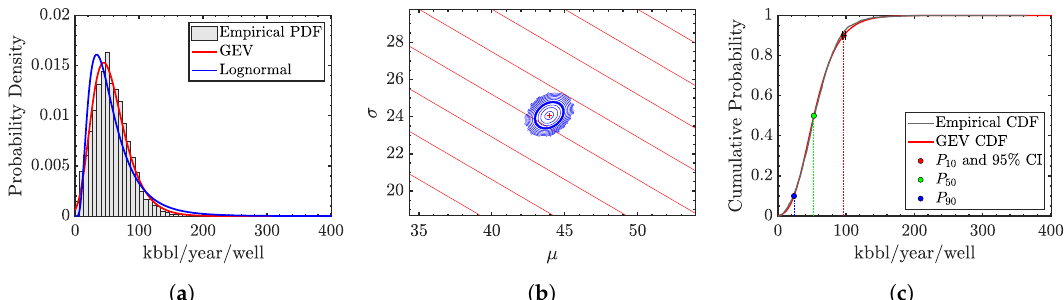
Figure 4. Distribution of oil production rates for 2540 horizontal wells with one year on production, completed between the year 2000 and 2012 in the Middle Bakken noncore area. ( a ) GEV PDF: ξ = − 0.0274, µ = 43.9421, σ = 24.0635. ( b ) Maximum Likelihood Estimate, 95% confidence interval (CI) for µ and σ . ( c ) GEV CDF with the 95% CI on the residual for the P 10